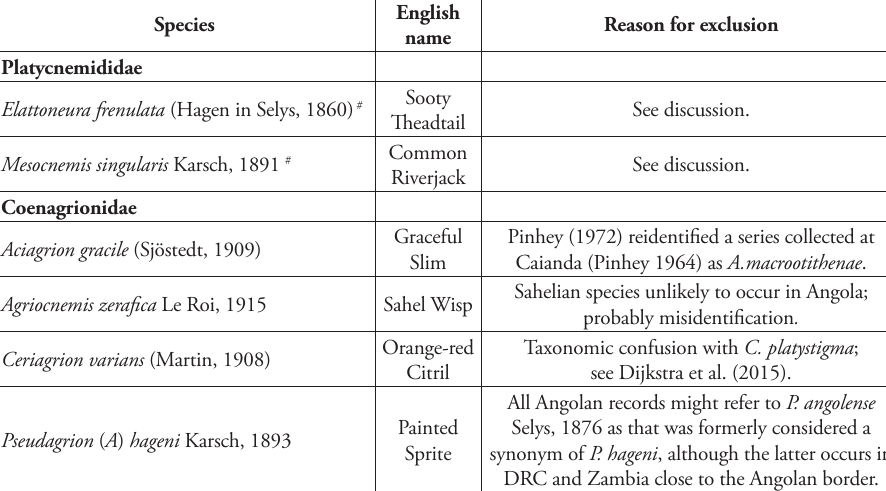
Table 2. Odonata species that have been removed from the list for